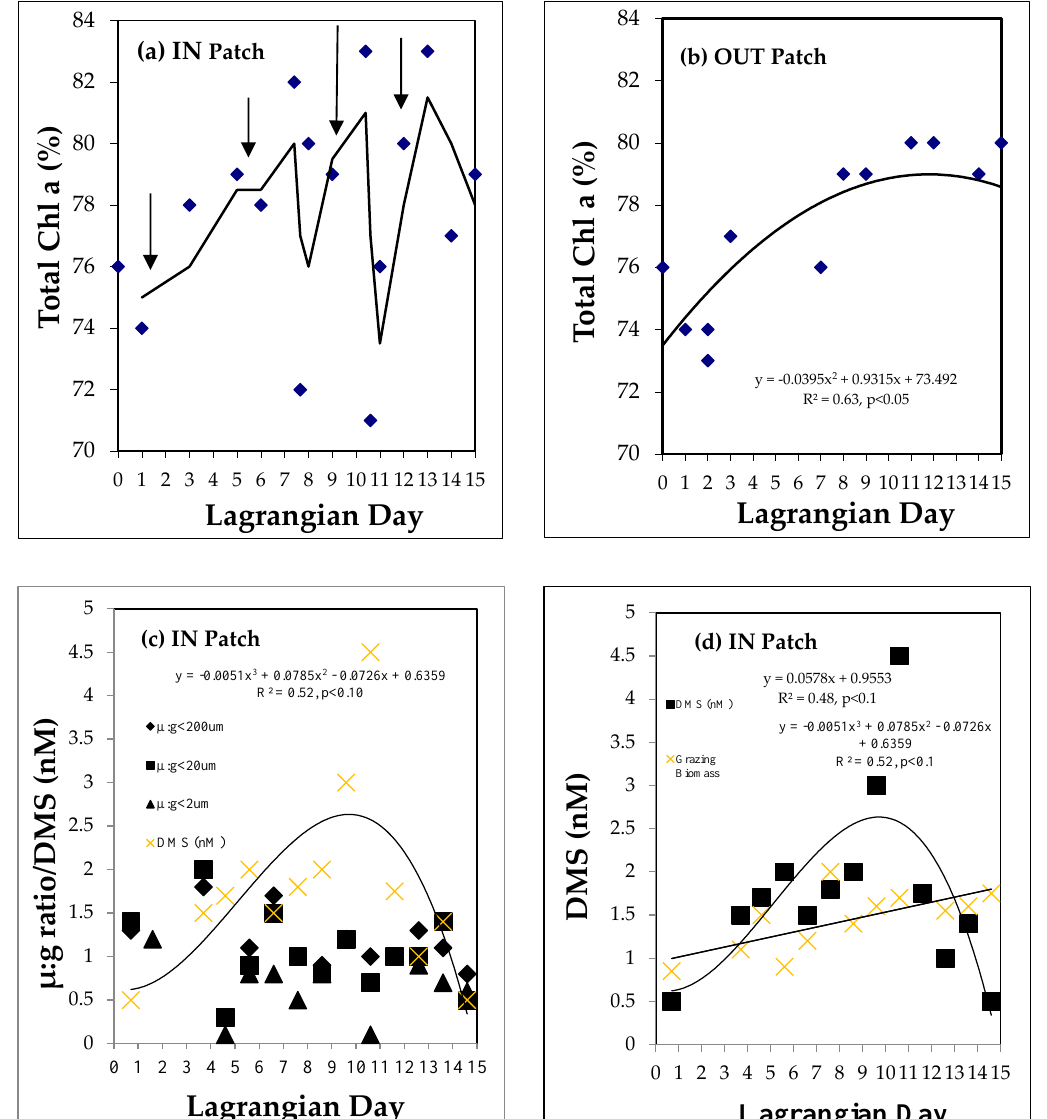
Figure 8. Percentage (%) of total Chl a in surface seawater (determined from CHEMTAX analysis of marker pigments) in prasinophytes, dinoflagellates, and hapto8s, over Lagrangian day, for the ( a ) IN patch (arrows = iron enrichment) and ( b ) OUT patch. ( c ) The ratio of the phytoplankton growth rate ( µ ) to microzooplankton grazing rate (g) for di ff erent size fractions (diamonds ≤ 200 µ m. full squares ≤ 20 µ m. triangles ≤ 2 µ m size fractions). crosses = DMS (nM). ( d ) Seawater DMS concentrations (nM) (squares) and the microzooplankton biomass (crosses) versus Lagrangian